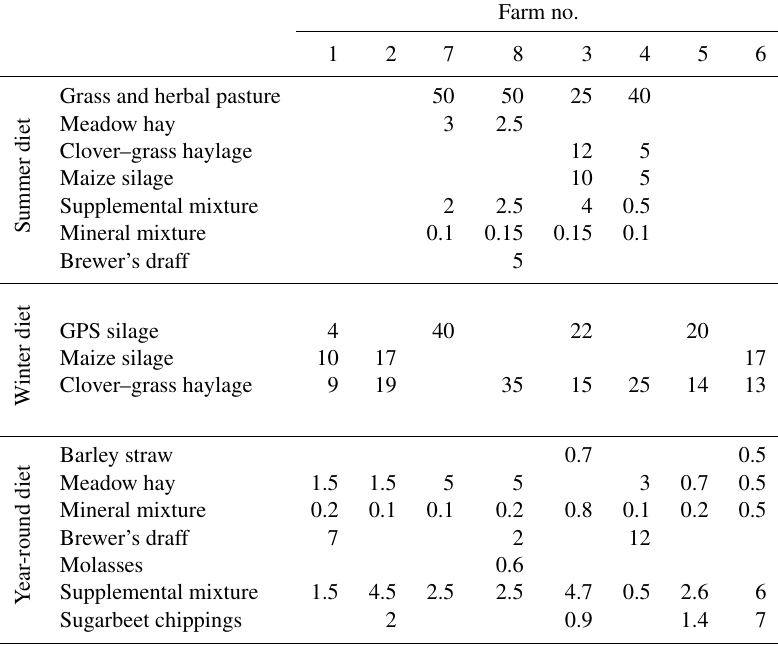
GPS silage: silage from whole maize plant in vax